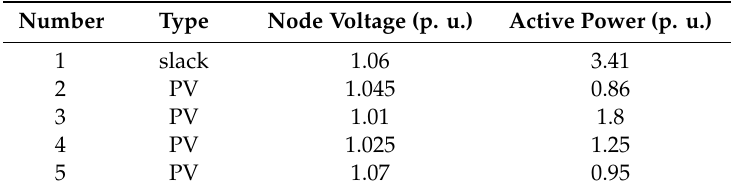
Table 2. Generator